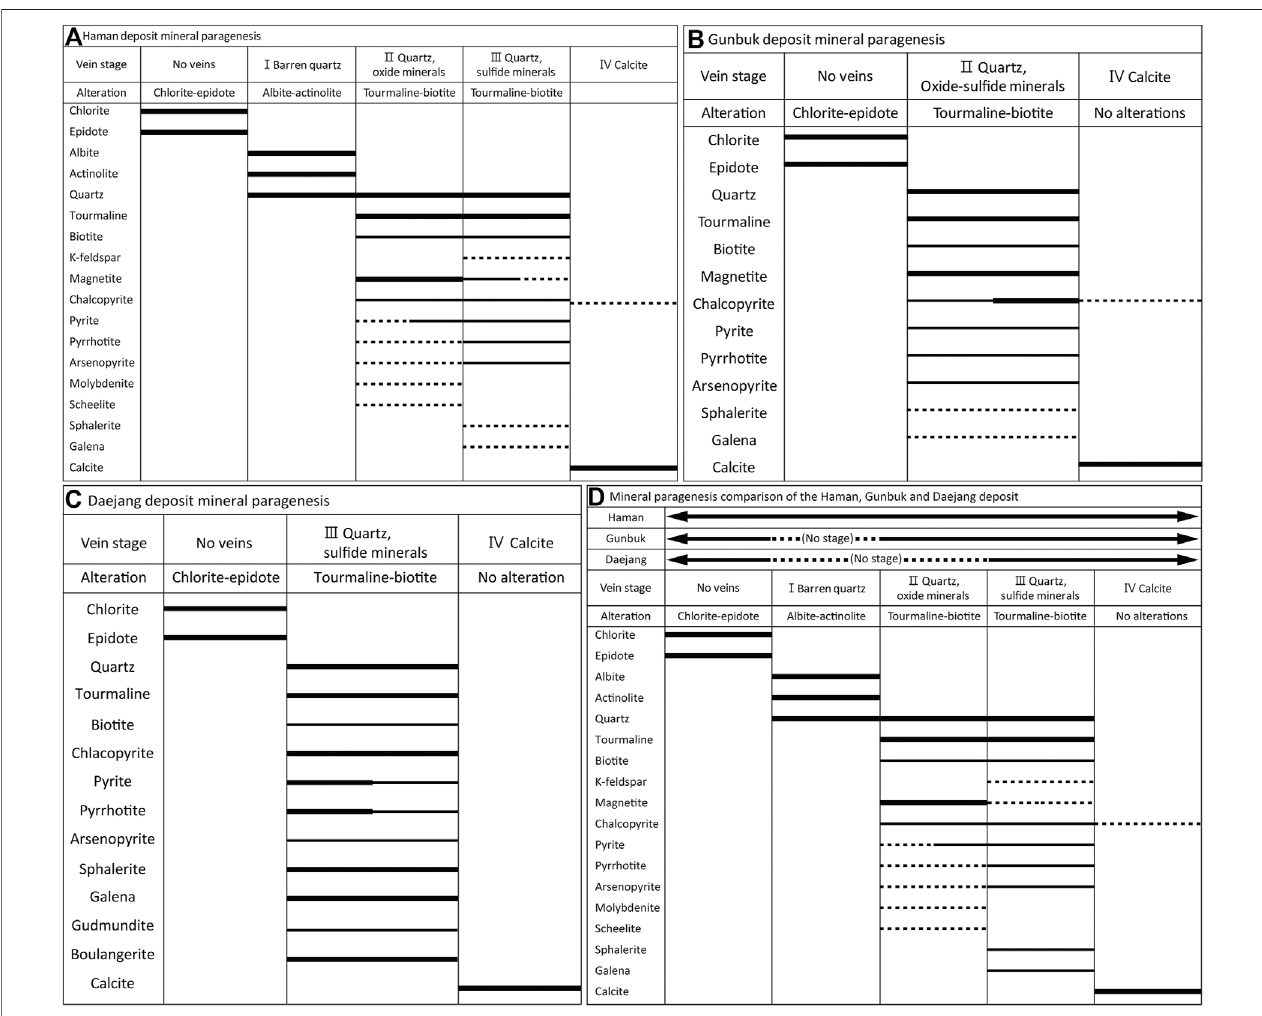
FIGURE 6 | Paragenetic relationships of veins, alterations, and minerals in the (A) Haman, (B) Gunbuk, and (C) Daejang deposits, and (D) a summary of the three deposits. Abundances of minerals occurring are represented by line thicknesses. In the three deposits, the chlorite-epidote alteration, tourmaline-biotite alteration with mineralized quartz veins, and the latest calcite veins are observed. Albite-actinolite alterations are observed only in the Haman deposit. In the Daejang deposit, gudmundite and boulangerite have been reported (Shin et al., 1987; Park and Kim, 1988; Choi, 1998), though they were not observed in this study.